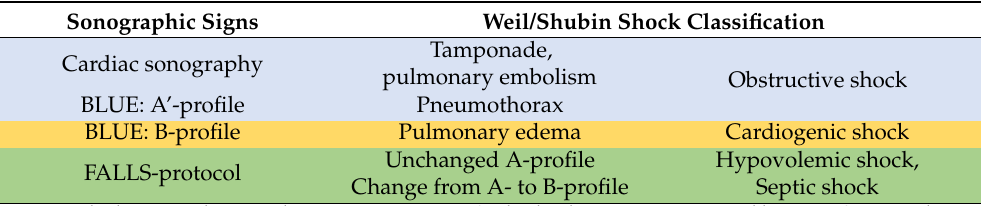
Table 2. Sequential differentiation of shock by sonography according to the FALLS-protocol [43,73]. Sonographic